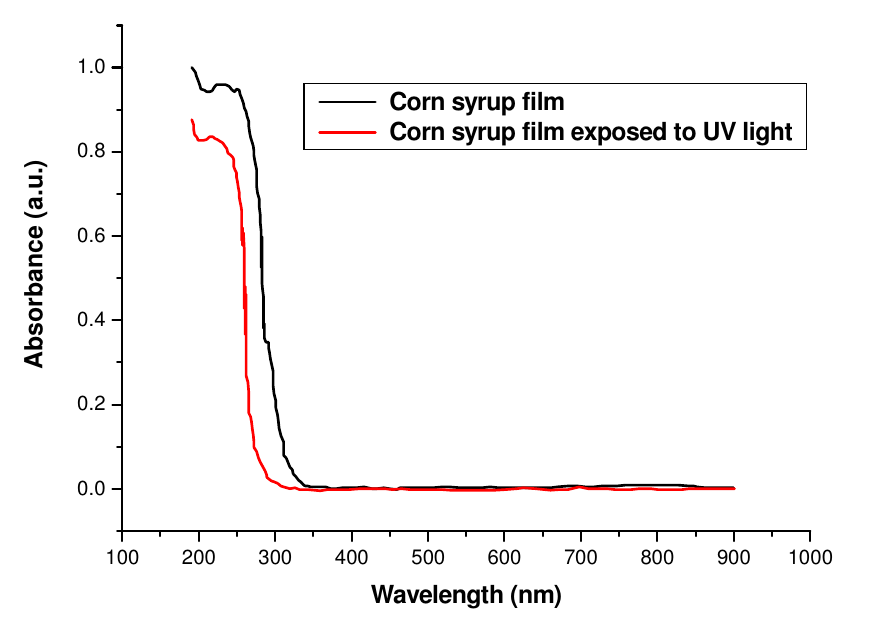
Figure 2. Absorbance versus wavelength, for a dry corn syrup layer of 10 µm